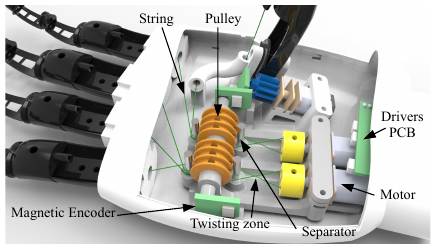
Figure 12. 3D model of the